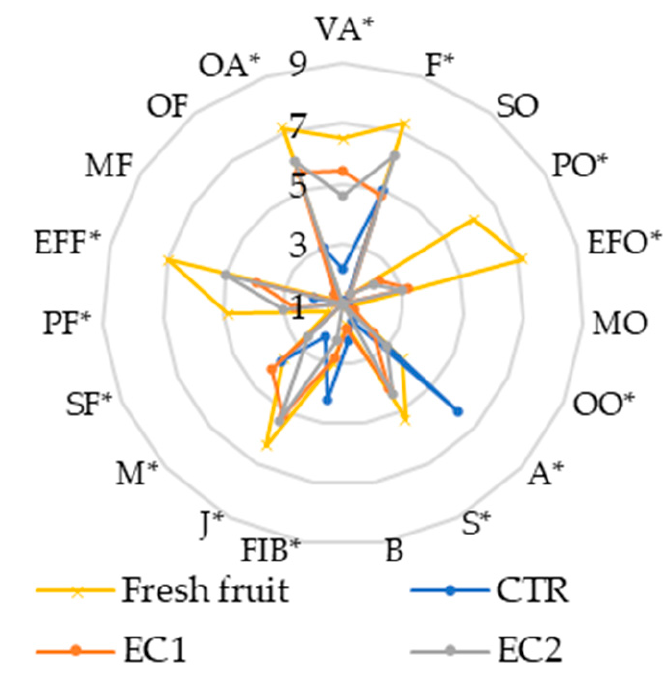
Figure 11. Sensory analyses of fresh-cut mango cubes after seven and nine days of cold